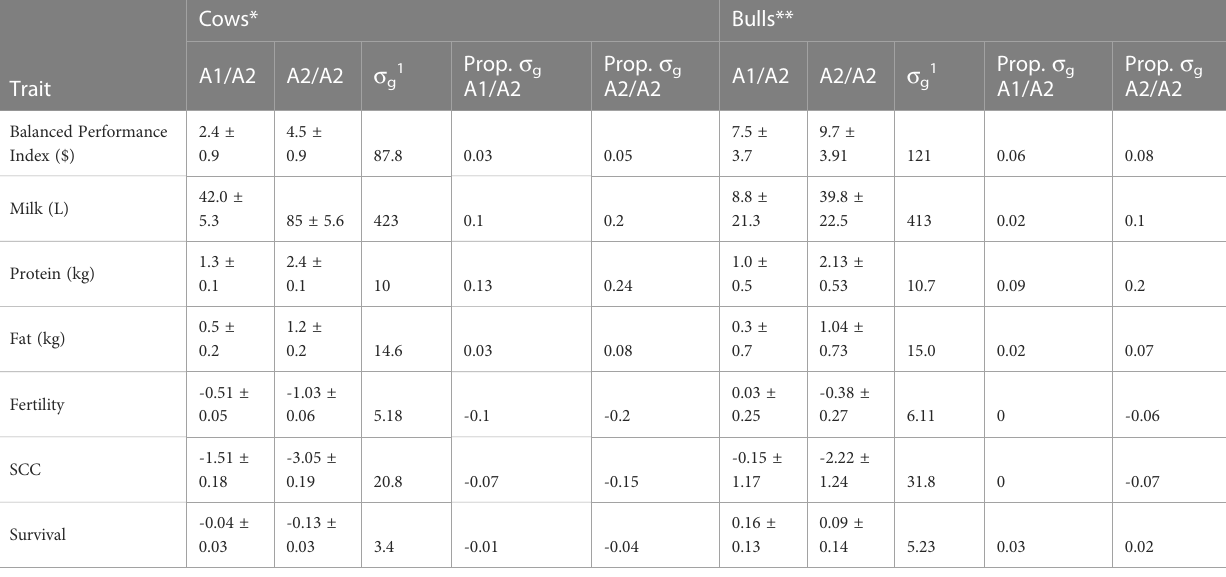
TABLE 2 Mean differences in estimated breeding values of bulls and cows that are A1A2 and A2A2 at the b -casein locus as a deviation from A1/A1 in EBV units and as a proportion of genetic standard deviations ( s g ) for the national selection index (Balanced Performance Index), production (milk, protein, and fat yields), fertility and health traits (somatic cell count (SCC) and Survival). Cows* Bulls** Prop. s g Prop. s g A1/A2 A2/A2 s g1 Trait A1/A2 A2/A2